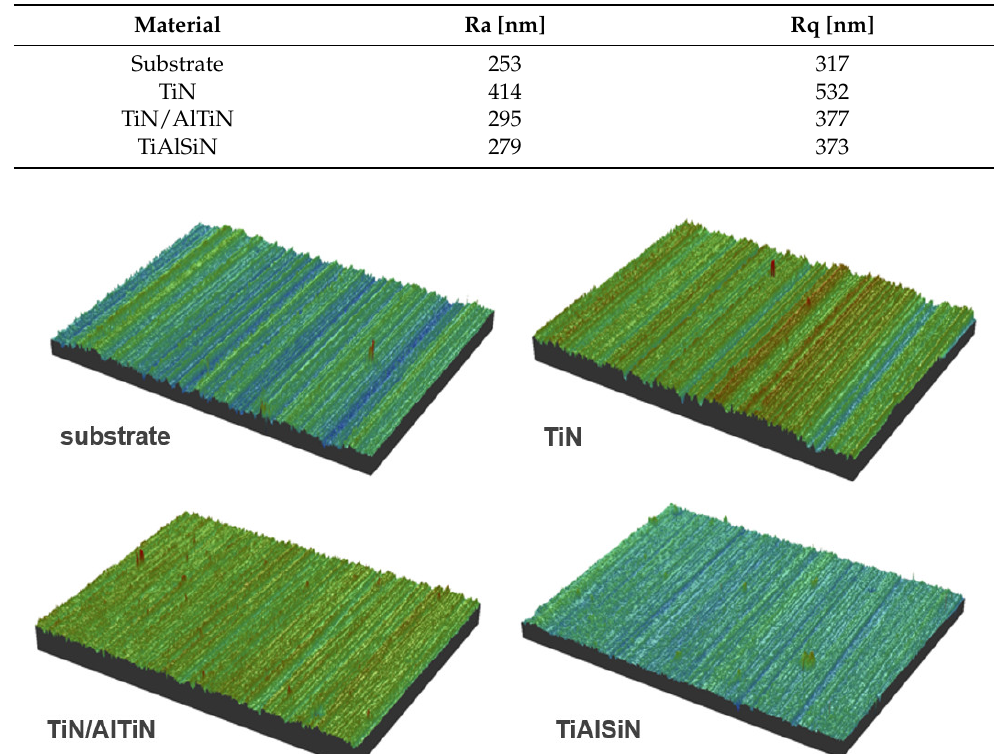
Table 2. Surface roughness parameters of substrate, TiN, TiN/AlTiN and TiAlSiN coatings.